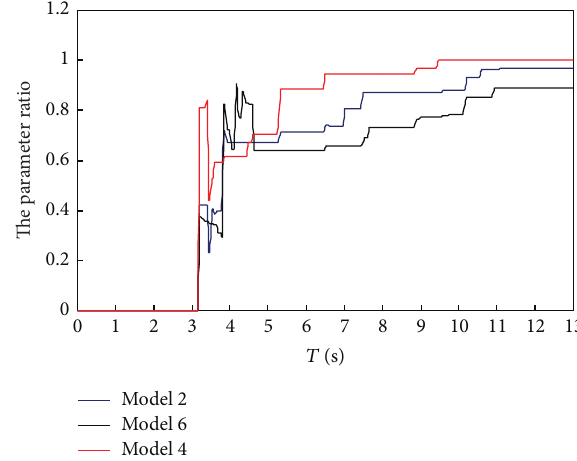
Figure 26: The tension crack damage parameter of spandrel under Wolong ground motion.